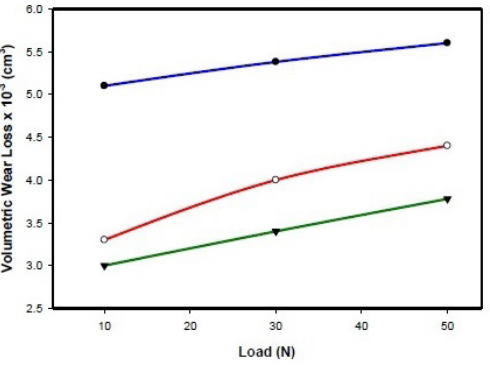
Figure 4. Volumetric wear loss of Al6061 alloy and reinforcement at varying loads and 400 rpm constant sliding speed (Blue - aluminium sample; Red – aluminium with 4% of reinforcement composite sample; Green – aluminum with 5% of reinforcement composite sample).